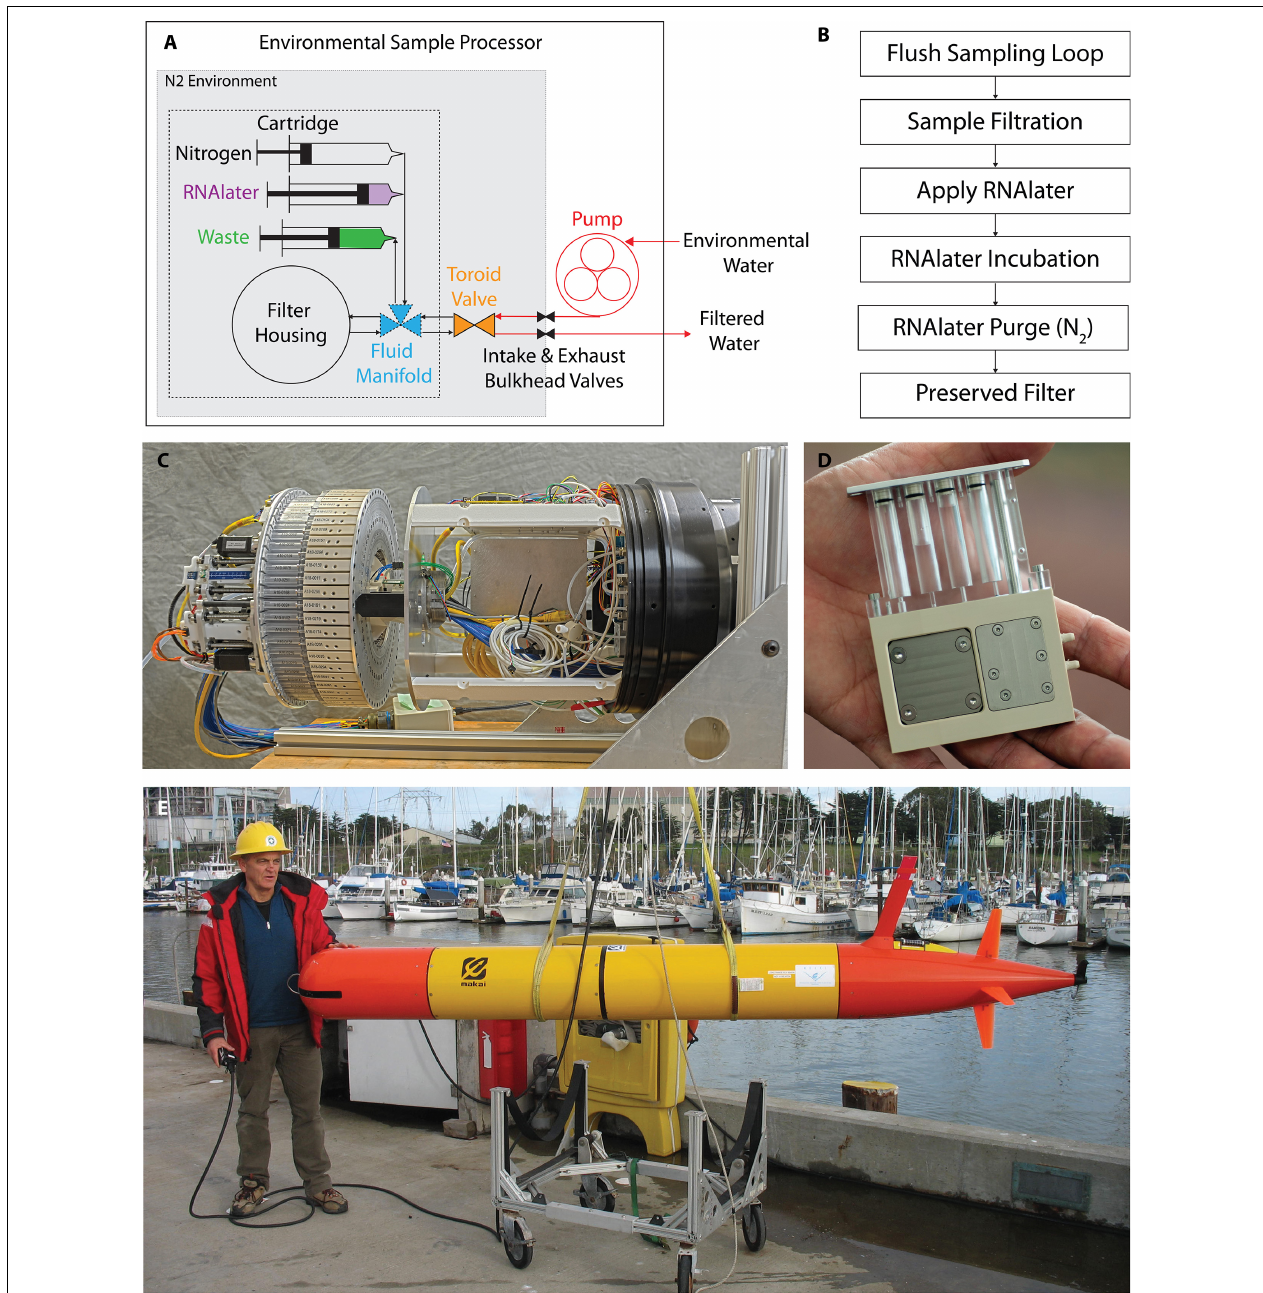
FIGURE 2 | Process flow diagram, schematic representation and photographs of the 3G-ESP. Schematic representation of the 3G-ESP (A) , main components of the 3G-ESP are shown: sampling loop with pump (red) and bulkhead valves (black), toroid valve (orange), and sampling cartridge. The sampling cartridge (within dashed lines) contains the filter housing, fluidic manifold (blue) for RNAlater R (cid:13) delivery (purple), nitrogen purging (gray), and waste recovery (green). All components within the 3G-ESP bulkhead valves (within the dotted lines) are stored under a nitrogen environment (gray). Sample processing flow diagram describes a simplified version of the sample processing on the 3G-ESP (B) . The 3G-ESP houses 60 cartridges arranged around a toroid valve, resulting in an instrument approx. 30 cm × 60 cm (C) . 3G-ESP sample collection and processing cartridge (D) . The design of 3G-ESP allows mounting as a payload on a long-range autonomous underwater vehicle (E) . All individuals shown in these photographs were informed prior to submission and have given written permission for the photographs to be used in this